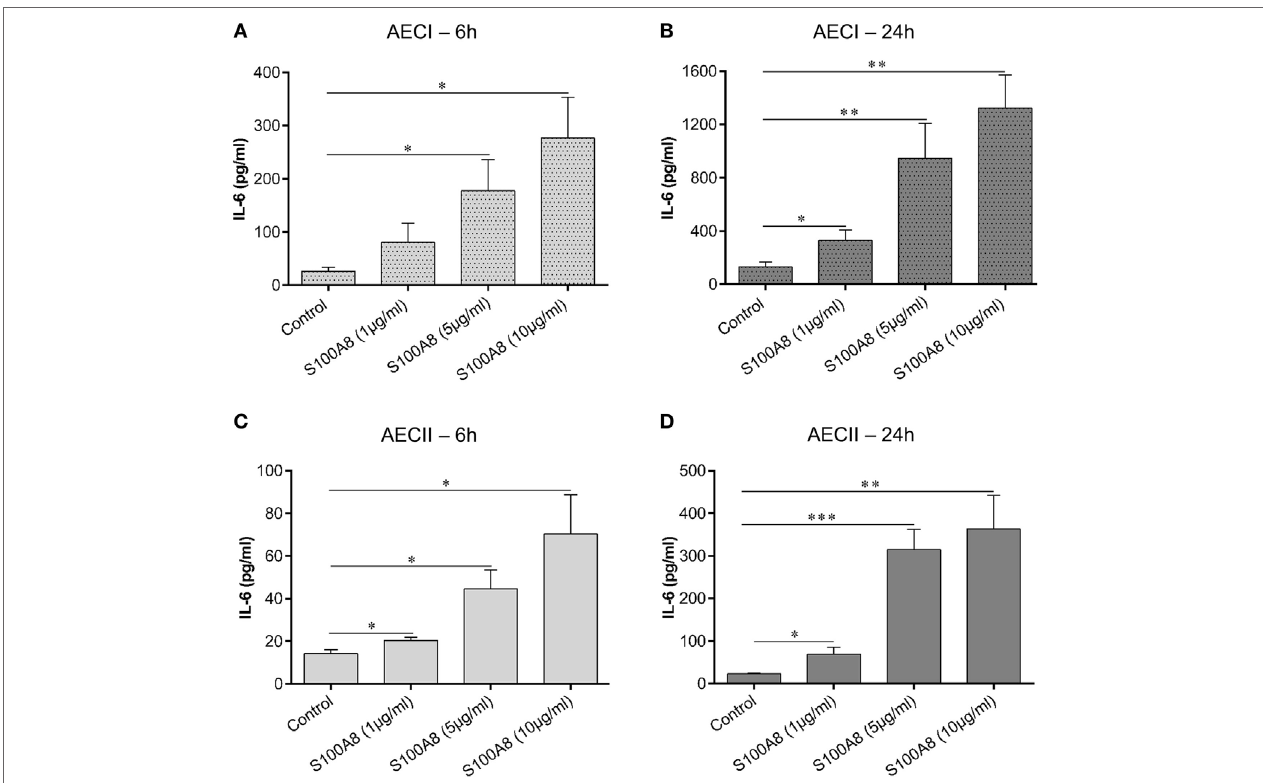
FigUre 2 | S100A8 activates alveolar epithelial type I cell (AECI) and type II cell (AECII) in a dose and time-dependent manner. AECI and AECII were stimulated for 6 h (a,c) and 24 h (B,D) with increasing amounts of murine S100A8 as indicated in the figure. The levels of IL-6 as a readout of epithelial cell activation was quantified by enzyme linked immunosorbent assay (ELISA). Data are expressed as mean ± SEM ( n = 4 experiments). * p < 0.05, ** p < 0.01, *** p < 0.001 compared to unstimulated cells